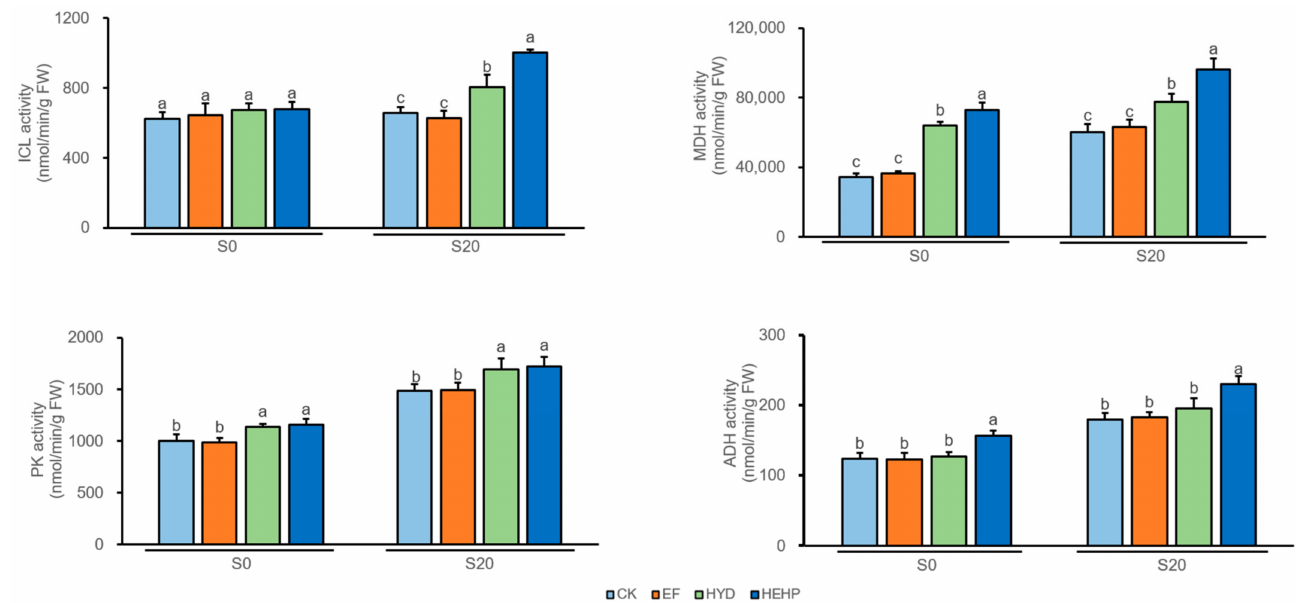
Figure 4. Changes of the key enzyme activities after different priming treatments. ICL, isocitrate lyase; MDH, NAD- dependent malate dehydrogenase; PK, pyruvate kinase; ADH, alcohol dehydrogenase. Values represent the means ± SE from three biological replications. The different lowercase letters above the bars indicate significant differences in 95% probability level ( p < 0.05, Duncan test was performed after ANOVA analysis).